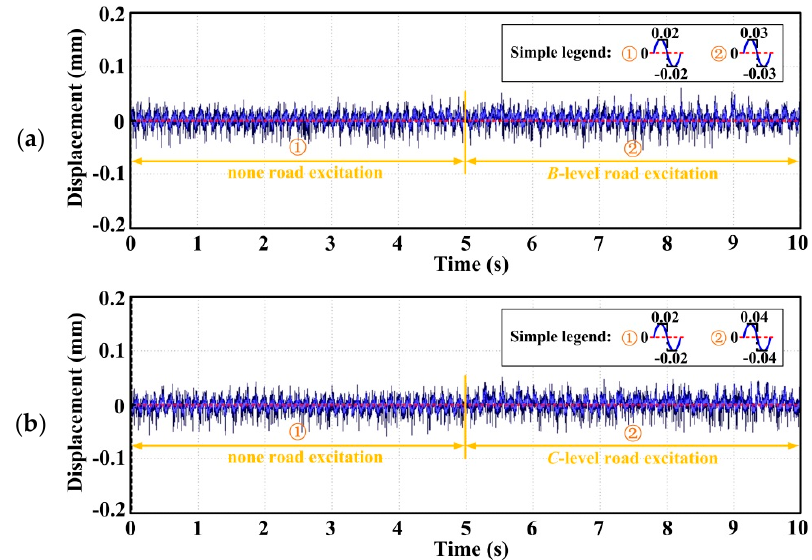
Figure 14. Axial displacement when different levels of sustained road surfaces are applied. ( a ) B-level road surface. ( b ) C-level road surface. road surface. ( b ) C-level road